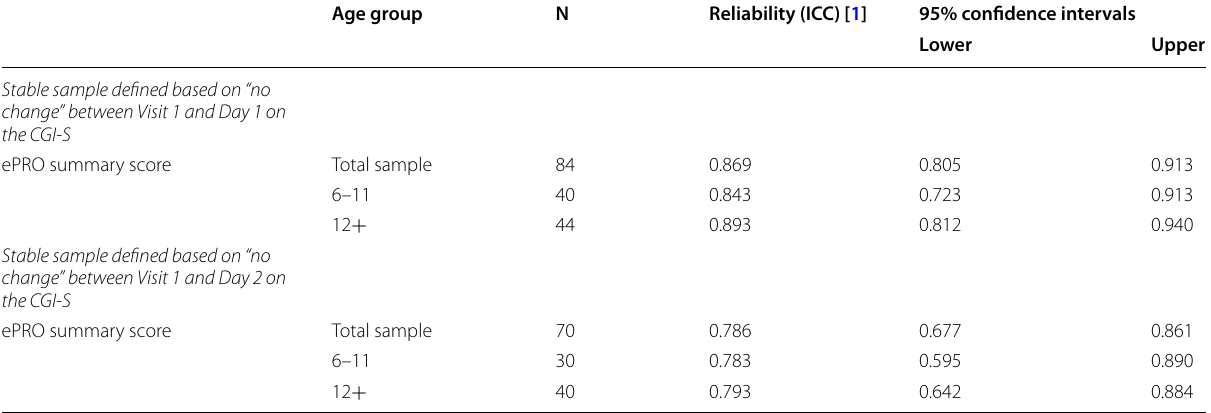
Table 5 Test-retest reliability for the chest-related ePRO summary score using the definitions based on the CGI-S